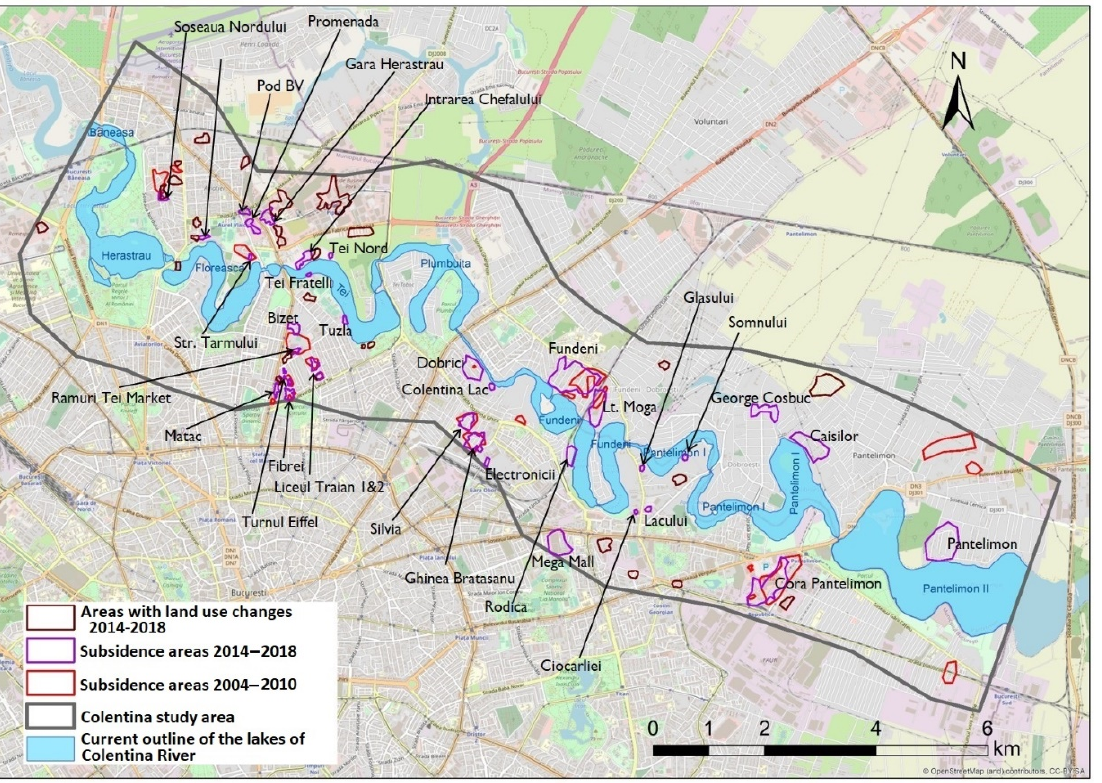
Figure 8. Areas showing land-cover changes and vertical displacements for the periods 2004–2010 and 2014–2018. Map generated in Esri ® ArcMap™ 10.3. Base map source: OpenStreetMap. Source: elaborated by the authors.